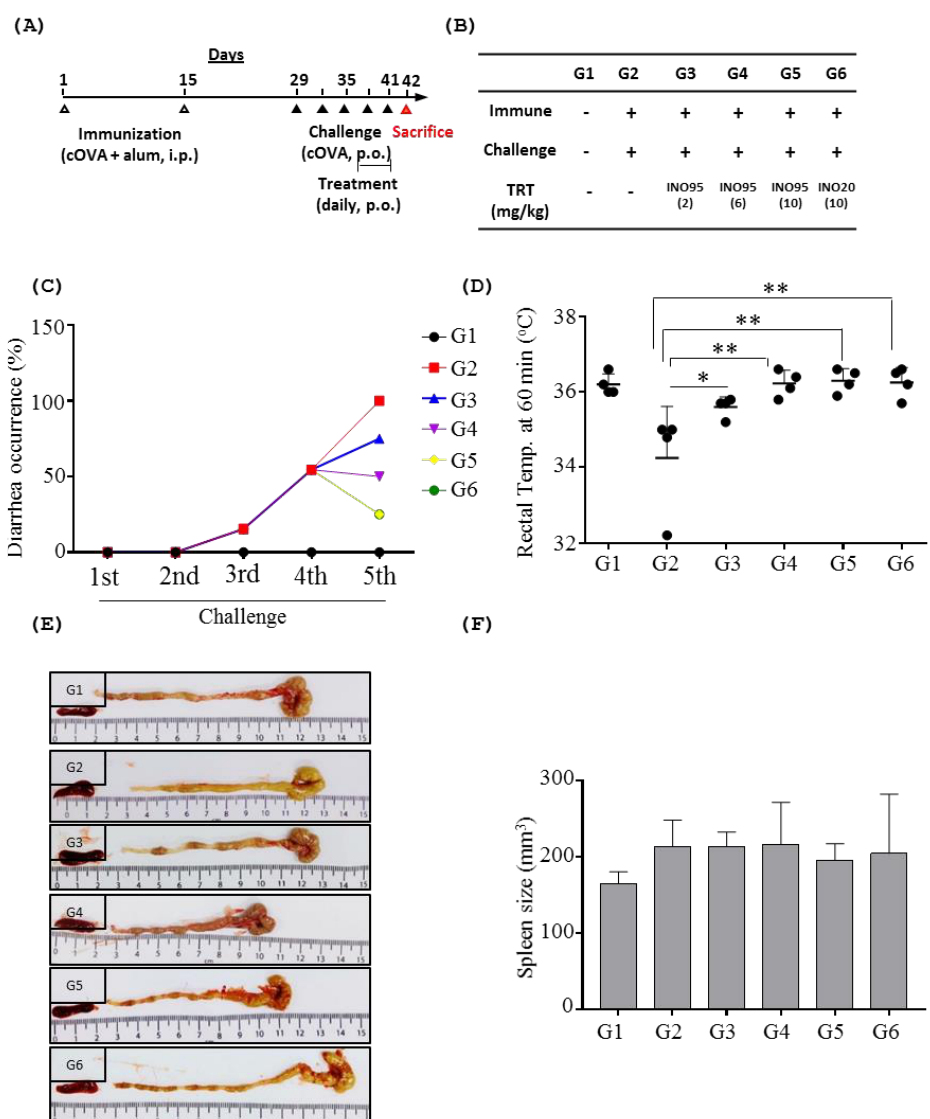
Figure 6. Effects of INO95 and INO20 on food allergic symptoms. Male BALB/C mice were divided into 6 groups and treated with either INO95 or INO20 from day 38 to day 41 once a day. On the day 41, mice were treated with compounds for 1 h, and then were challenged with cOVA. One hour later, clinical symptoms were recorded. ( A ) The experimental scheme is shown. ( B ) The description of each treatment group is shown in the table. ( C ) Diarrhea occurrence was recorded during challenge period. ( D ) Rectal temperature was measured 1 h after the fifth cOVA challenge. On day 42, mice were sacrificed to check organs and blood. ( E ) The morphology pictures of spleen and colon were shown. ( F ) The size of spleen was measured. Significantly different from sham group p < 0.05 (*), p < 0.005 (**), as determined by one way ANOVA test. The data shown represent mean ± S.D. ( n = 4).